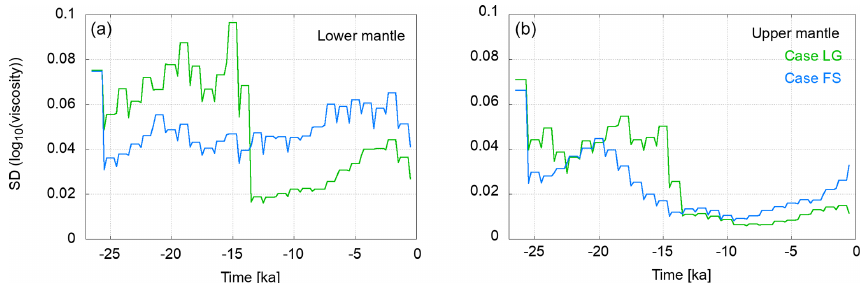
Figure 16. Variation in the ensemble standard deviation of log 10 (ν) over time (green – Laurentide and Greenland; blue – Fennoscandia). Panel (a) shows the values for the lower mantle, and panel (b) shows the values for the upper mantle, respectively. The points at the beginning and end of each plateau represent the ensemble at the beginning and end of a forecast phase. They are equal since, during the forecast, the viscosity remains unchanged. The drop after a plateau happens due to resampling and the subsequent rise due to perturbation (although this happens at the same point in time, the values are shifted horizontally to visualise the variation).